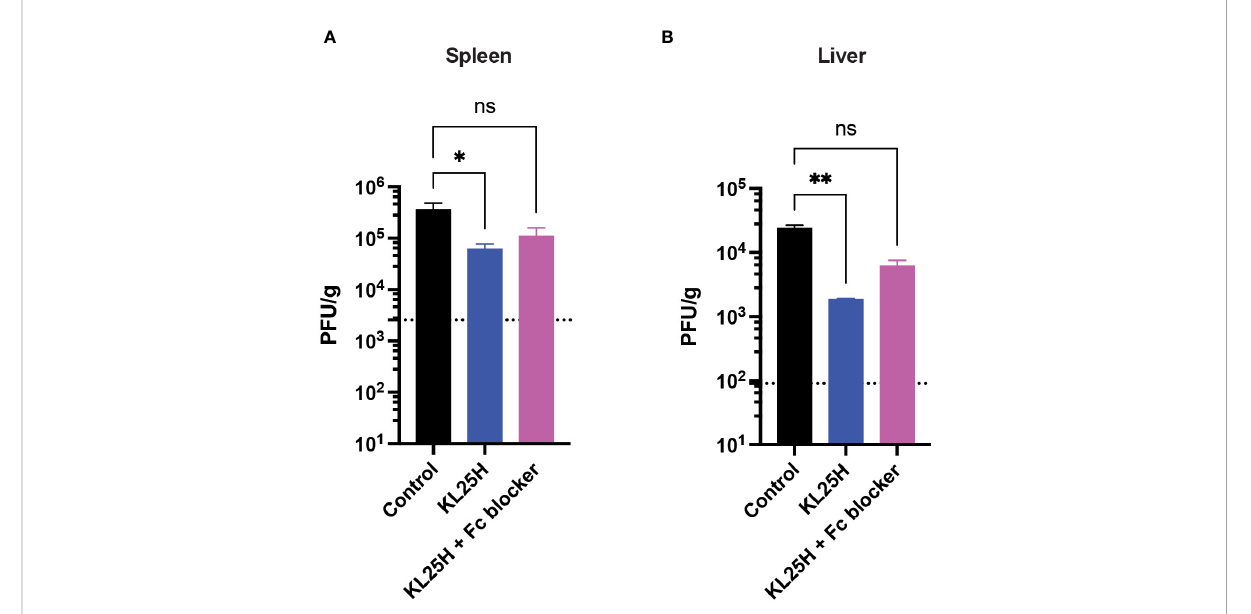
FIGURE 5 The ef fi cacy of adoptive B cell therapy is partly dependent on antibody effector functions. An Fc receptor blocking antibody (2.4G2) was administered intraperitoneally every three days, fi ve times (500 m g/dose). (A) Summary of viral loads in spleen. (B) Summary of viral loads in liver. Experiments were performed 2 times, n=3-5 mice per experiment. Error bars represent SEM. The P values were calculated using the Kruskal- Wallis non-parametric ANOVA test. ns, not signi fi cant. * P <0.05, *** P <0.0005, ****P<0.0001. Dotted line represents limit of